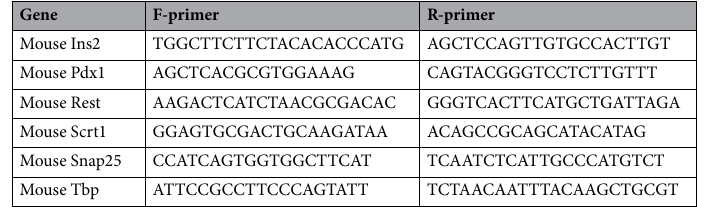
Table 3. qPCR Primer Sequences